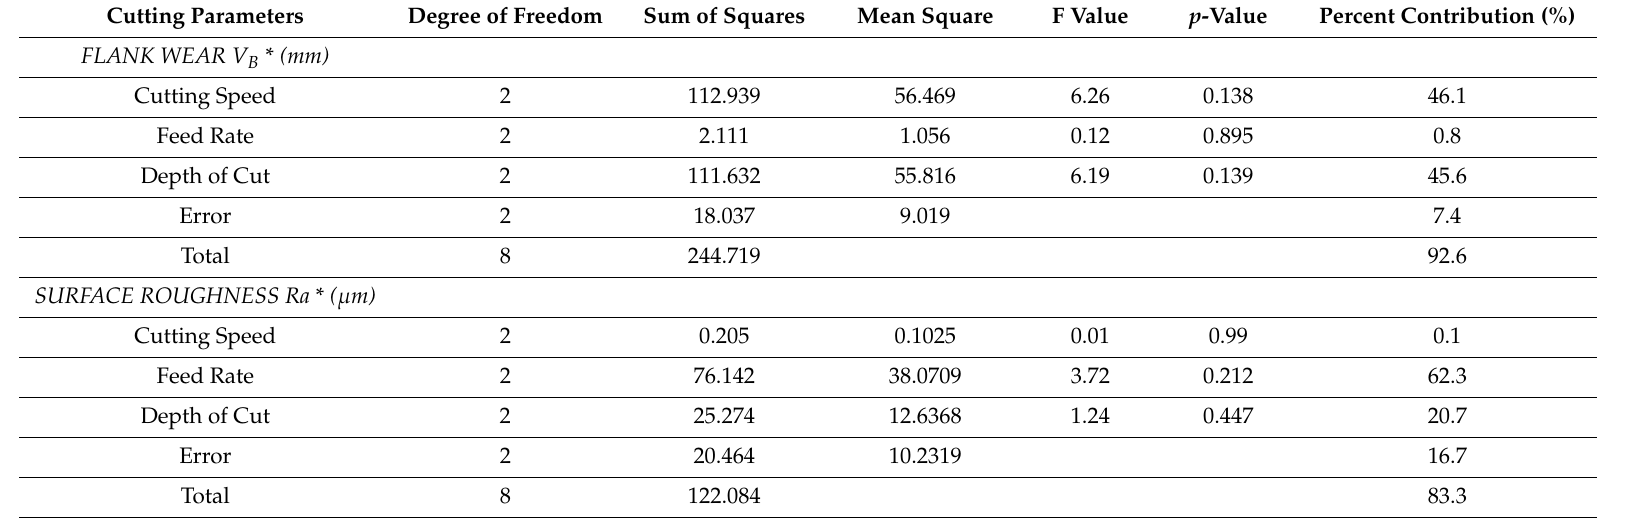
Table 5. Analysis of Variance results for response parameters, namely flank wear, surface roughness.